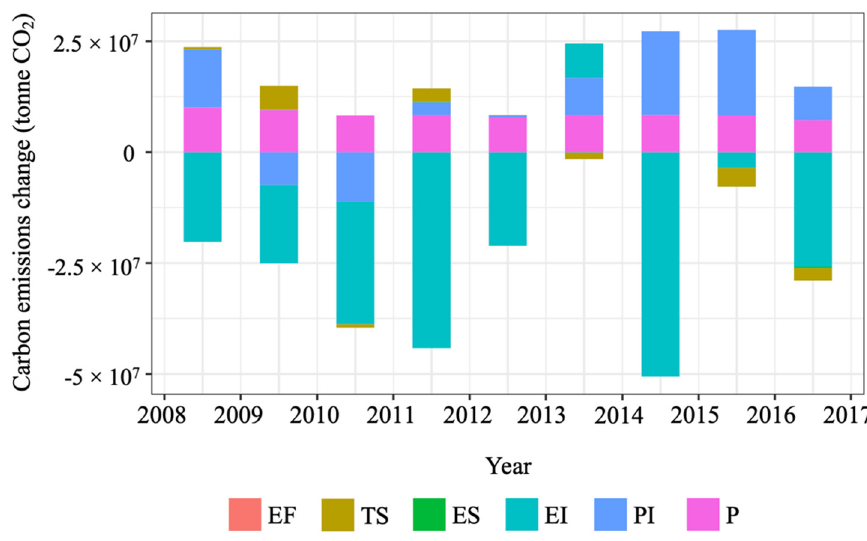
Figure 2. Decomposition results for the U.S. CO 2 emissions of road passenger transport.